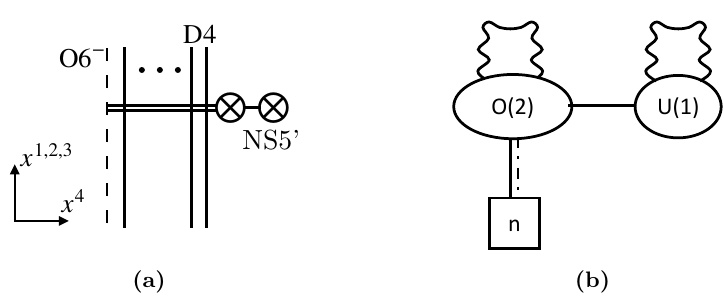
Figure 26. (a): the brane configuration for the monopole screening sector v = 0 of T V · T V in the N = 2 ∗ USp(2 n ) gauge theory. (b): the corresponding quiver